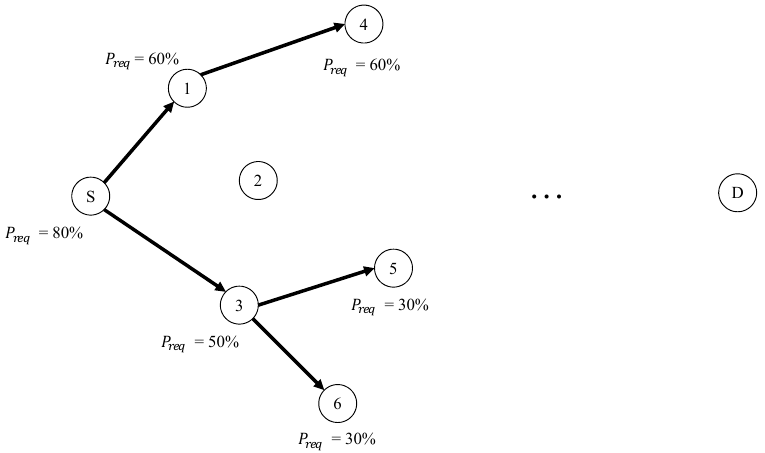
Figure 3. An example of the bifurcation transmission process and P req